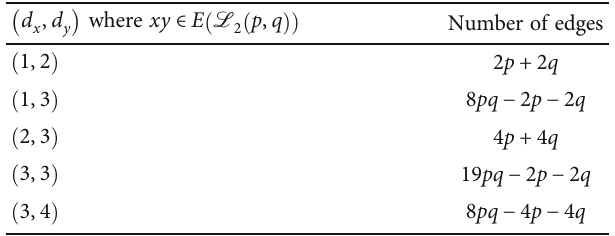
Table 3: The edge partition of L end vertices of each edge.